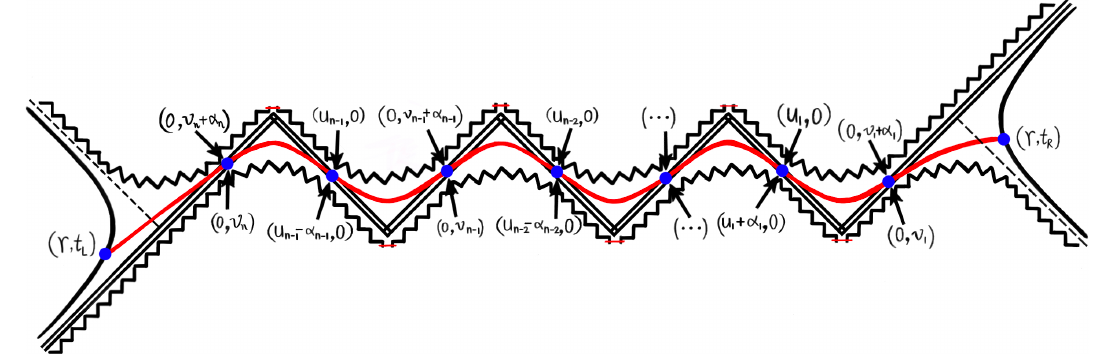
Figure 1 . Kruskal diagram for an ERB dual to the TFD state that is perturbed at the left boundary by out-of-time-order operators [28]. The maximum-volume surface that crosses the ERB is shown by the red curve. There are two sets of ( u, v ) coordinates for each point of junction with a shock: one in the patch to the left and one in the patch to the right. The intensity of each shock determines the null shifts that link